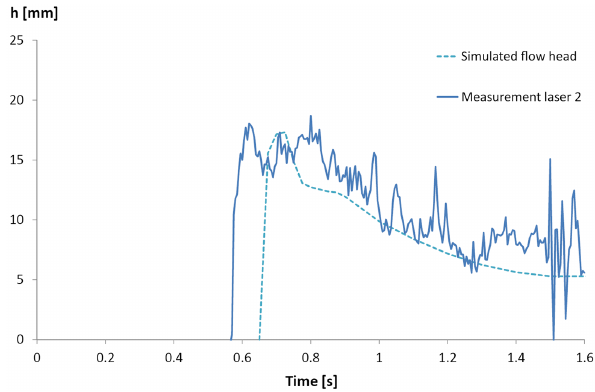
Figure 6. Laser measurement and corresponding simulated values of the flow head over time, 1m downslope of the gate for hillslope debris-flow flume experiments with water content of 28.5%. The laser data were box averaged over